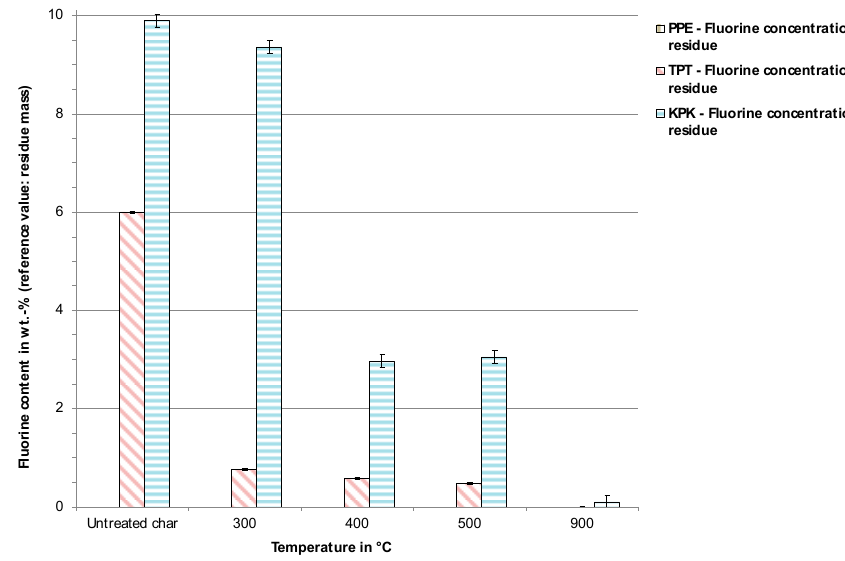
Figure 6. Incineration of residual pyrolysis char and fluorine concentration.